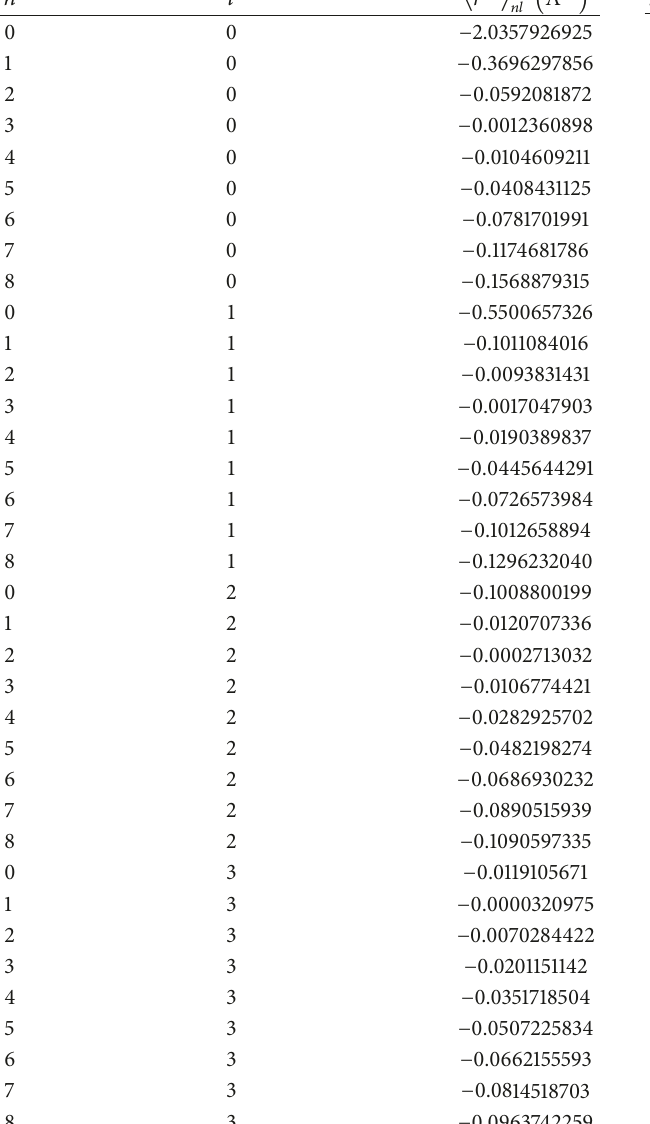
Table 2: Expectation values of ⟨𝑟 −2 ⟩ for hydrogen molecule. Table 3: Expectation values of ⟨𝑟 −2 ⟩ for lithium hydride